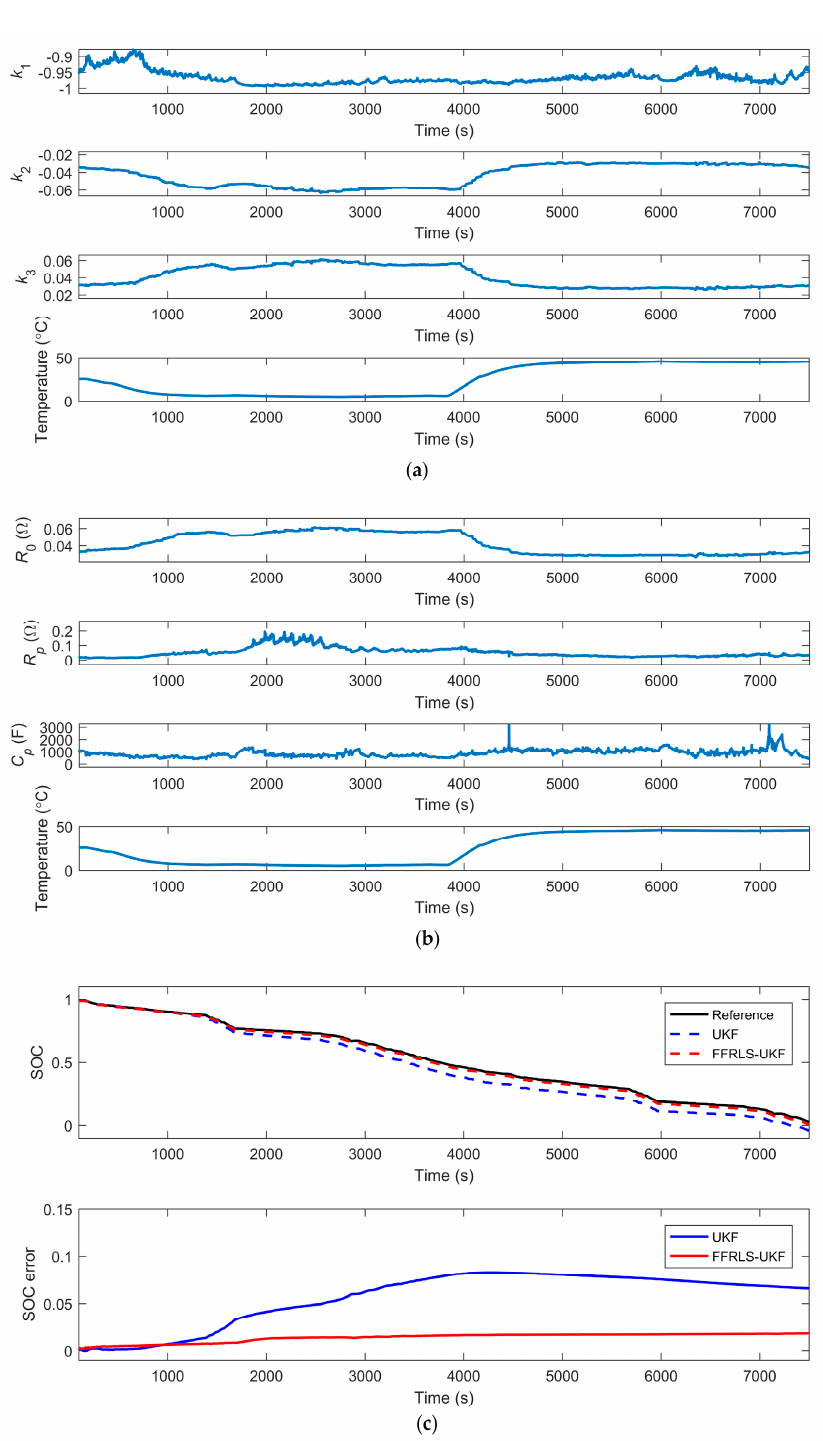
Figure 11. Calculation results of UKF and FFRLS-UKF with measurement noise: ( a ) Identification of k 1 , k 2 and k 3 ; ( b ) Identification of R 0 , R p and C p ; ( c ) SOC estimation results of UKF and FFRLS-UKF.